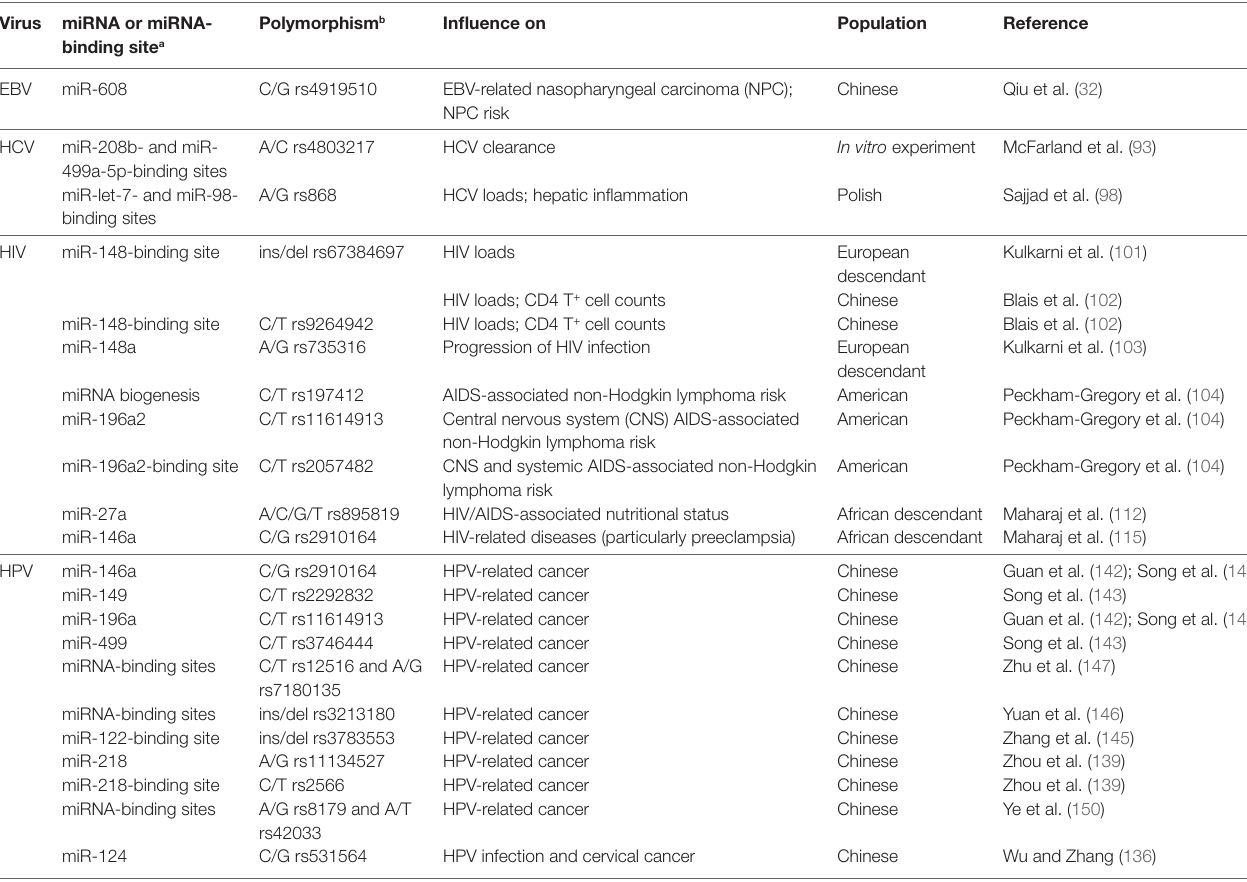
TABLe 2 | Main microRNAs (miRNA)-related polymorphisms showing statistically significant influence on Epstein–Barr virus (EBV), hepatitis C virus (HCV), human immunodeficiency virus (HIV), and Human Papillomavirus (HPV)